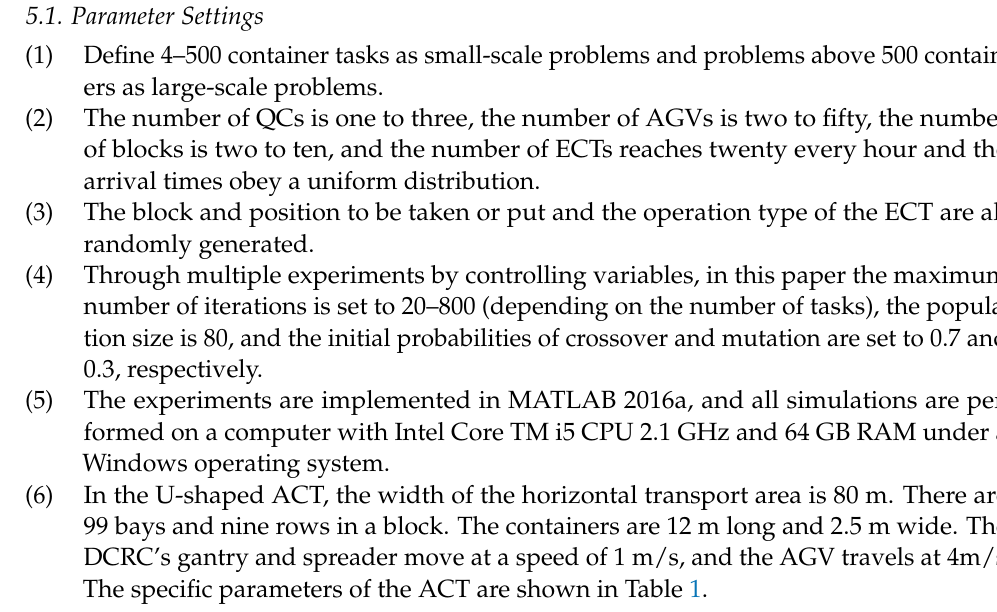
Table 1. ACT parameters.